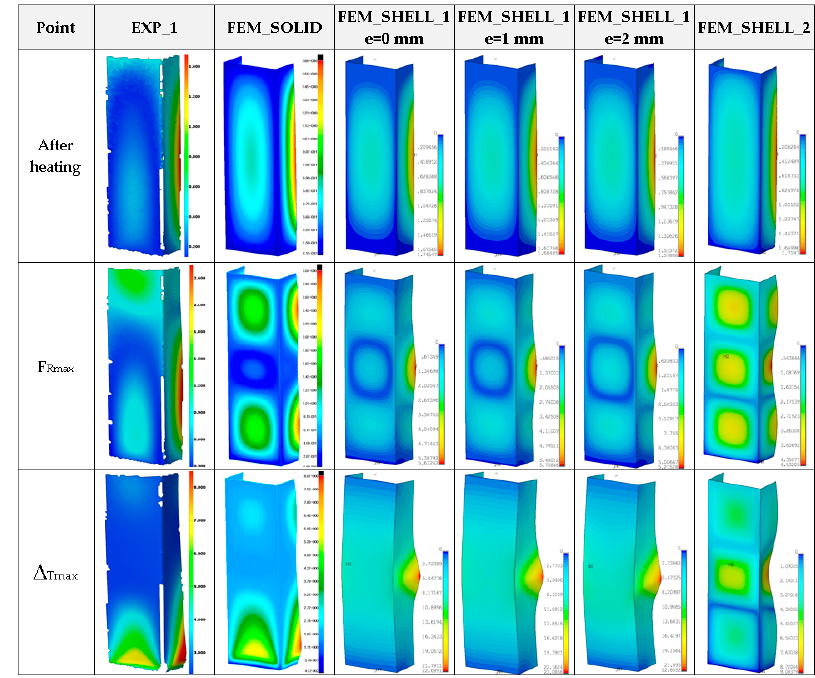
Figure 13. Deformation maps of columns at 50 °C.